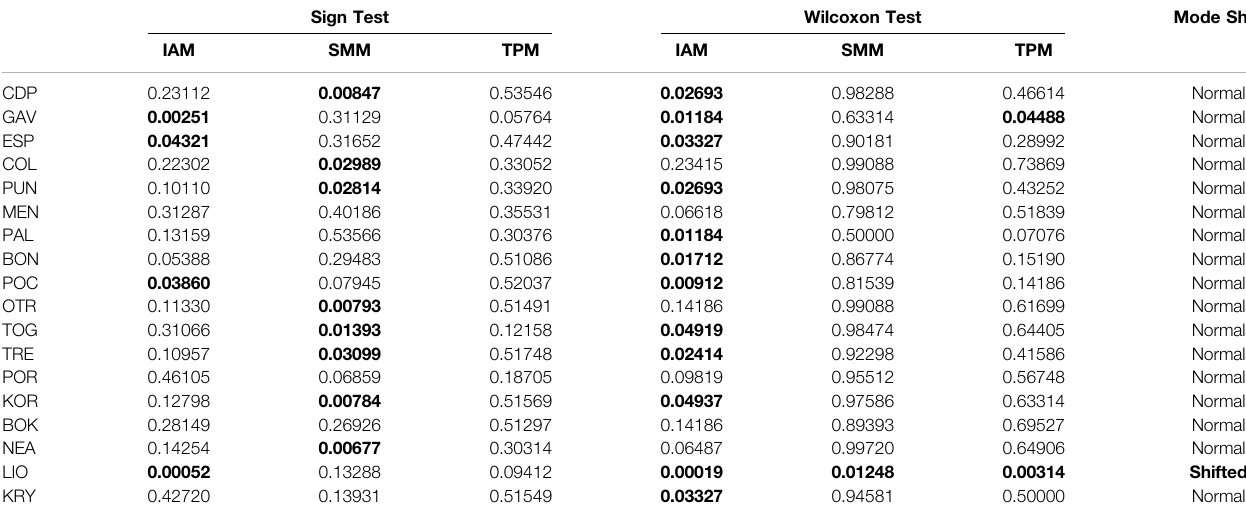
TABLE 7 | Bottleneck analysis results for the analysed populations of C. caespitosa